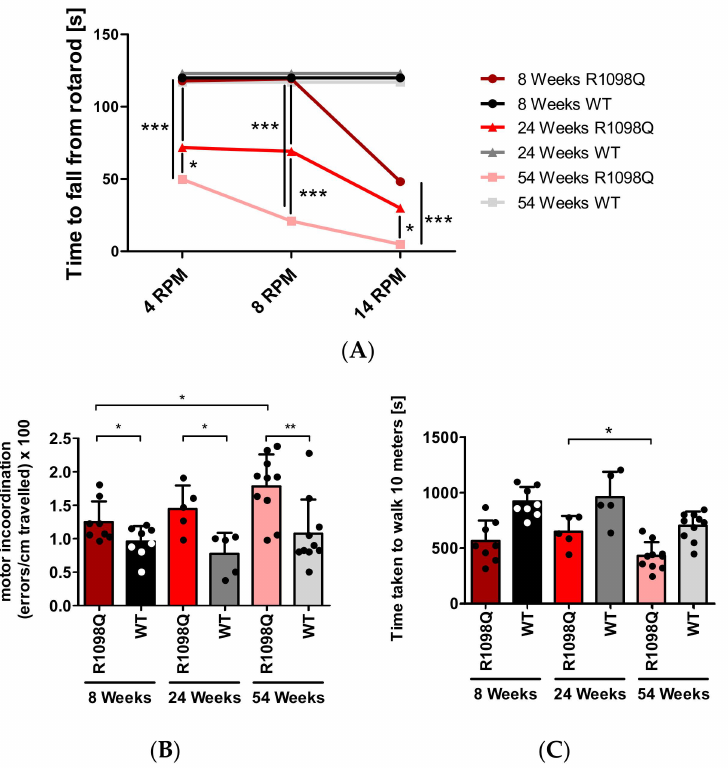
Figure 1. Progressive motor impairment in R1098Q mice: ( A ) Constant speed rotarod. The graph shows the mean time taken to fall off the rotarod for three age groups of R1098Q mice and control WT littermates. All the WT mice achieved a maximum latency of 120 s. The graphs of WT performance were separated for better readability of the results, otherwise, they would overlap. The numbers of animals per group were as follows: the 8-week-old group (WT, n = 5; R1098Q, n = 7), the 24-week-old group (WT, n = 7; R1098Q n = 7), the 54-week old group (WT, n = 6; R1098Q n = 7). ( B ) parallel rod floor test: ( C ) open field test. The bars represent the mean of the group, and the dots represent the mean result of four trials per mouse. The tests shown in panels B and C were performed on the following numbers of mice per group: the 8-week-old group (WT, n = 8; R1098Q, n = 8), the 24-week-old group (WT, n = 5; R1098Q n = 5), and the 54-week-old group (WT, n = 10;